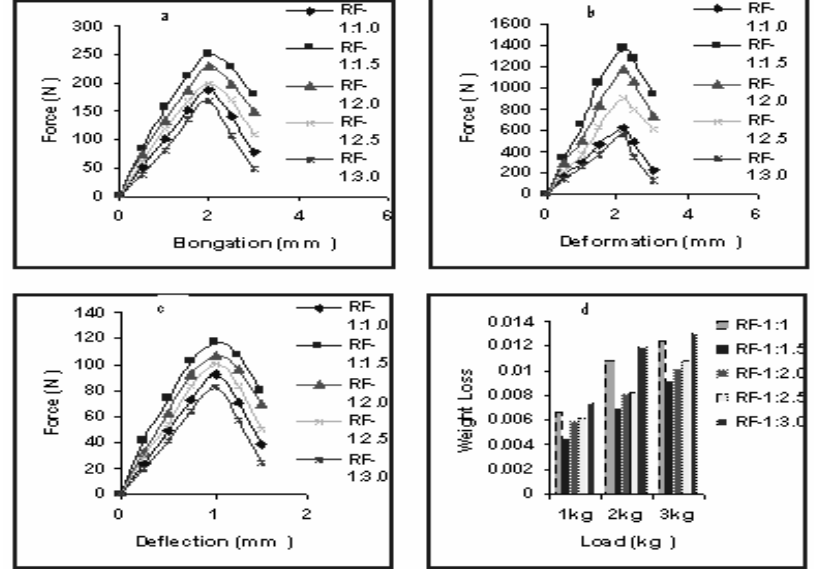
Figure 1. Load elongation/deformation/deflection & wear resistance curve of RF resin (a, b, c, d). Effect of pine needles reinforcement on the mechanical properties of R-F